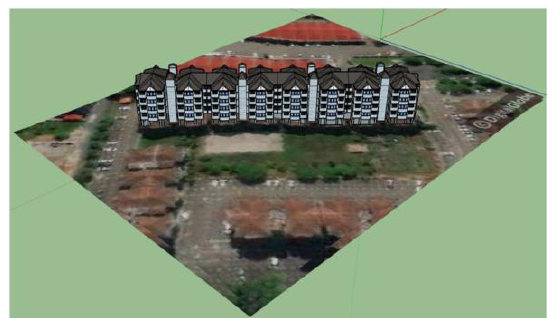
Figure 3. shows the result of 3D model